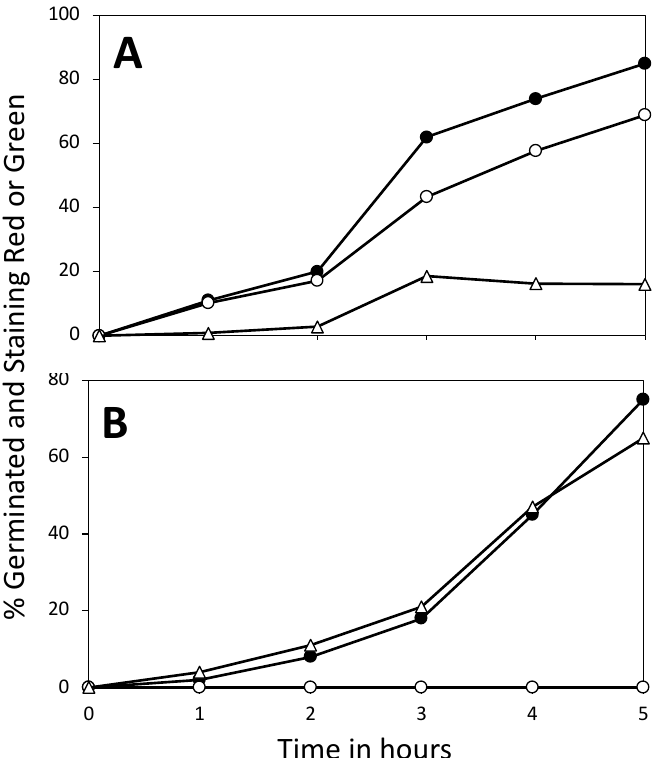
Figure 4. ( A , B ) Germination and viability of spores incubated with CaDPA. The spores of the strains ( A ) PS832 (wt and have 3PGA) and ( B ) PS3406 (CaDPA-less and have no 3PGA) were incubated at 23 °C with 50 mM CaDPA (pH 7.5); spore germination was measured by phase contrast microscopy ( • ) and the levels of germinated spores stained red ( (cid:52) , dead) or green ( , alive) were measured by fluorescence microscopy upon BacLight staining, as described in the Methods section.